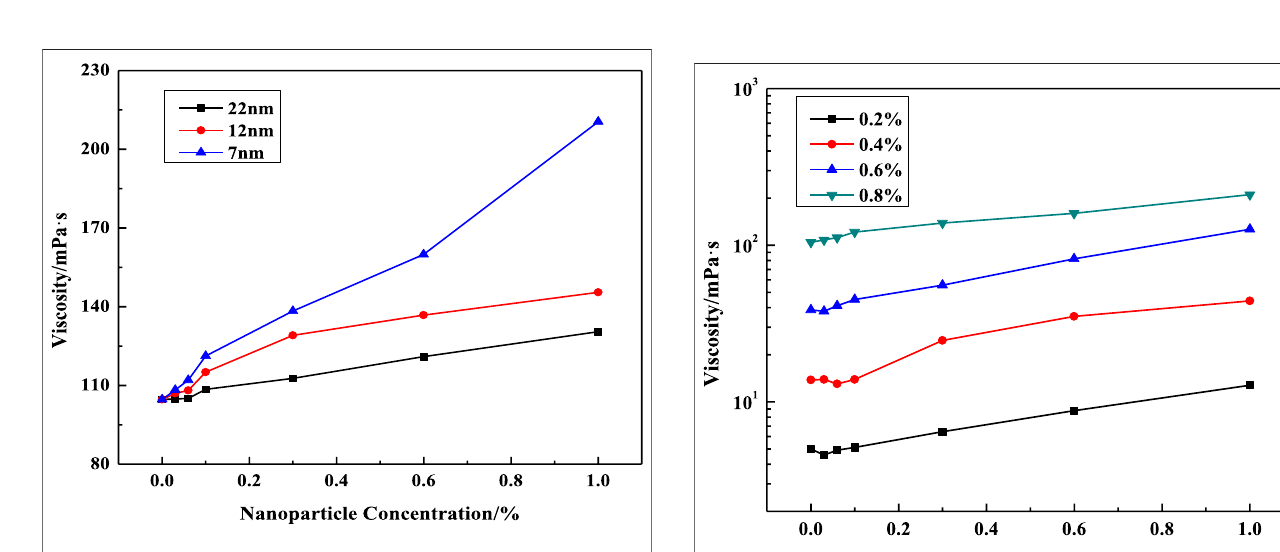
FIGURE 6 | Effect ofSiO 2 concentration on solution viscosity at different nanoparticle diameters ( w (LBA + SDS) (cid:2) 0.8%, LBA:SDS (cid:2) 3:1, T (cid:2) 50 ° C, w (NaCl) (cid:2) 4%, γ (cid:2) 7.34s − 1 ).